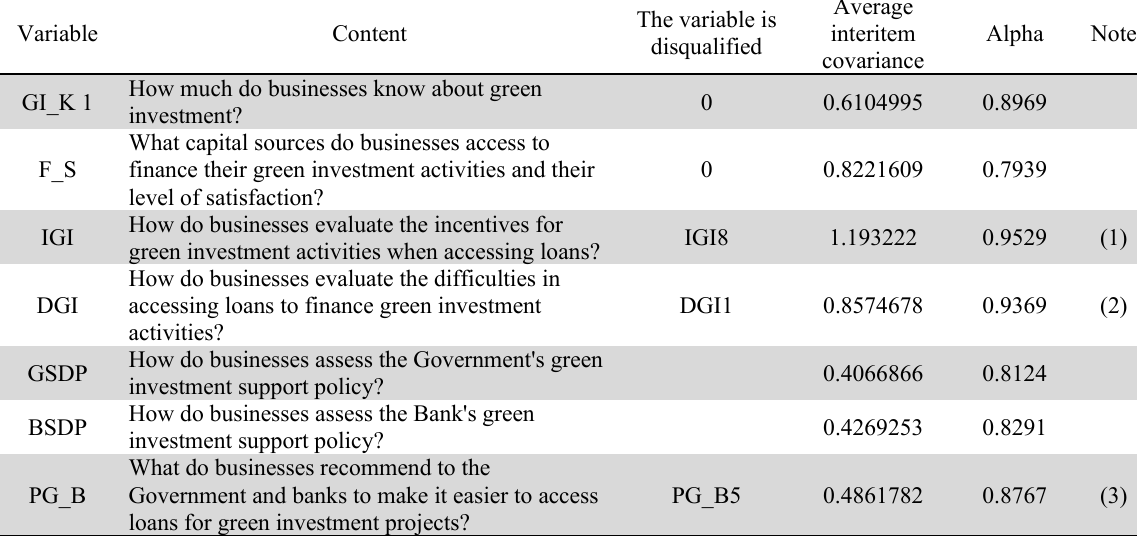
The results of for factors of green investment of businesses